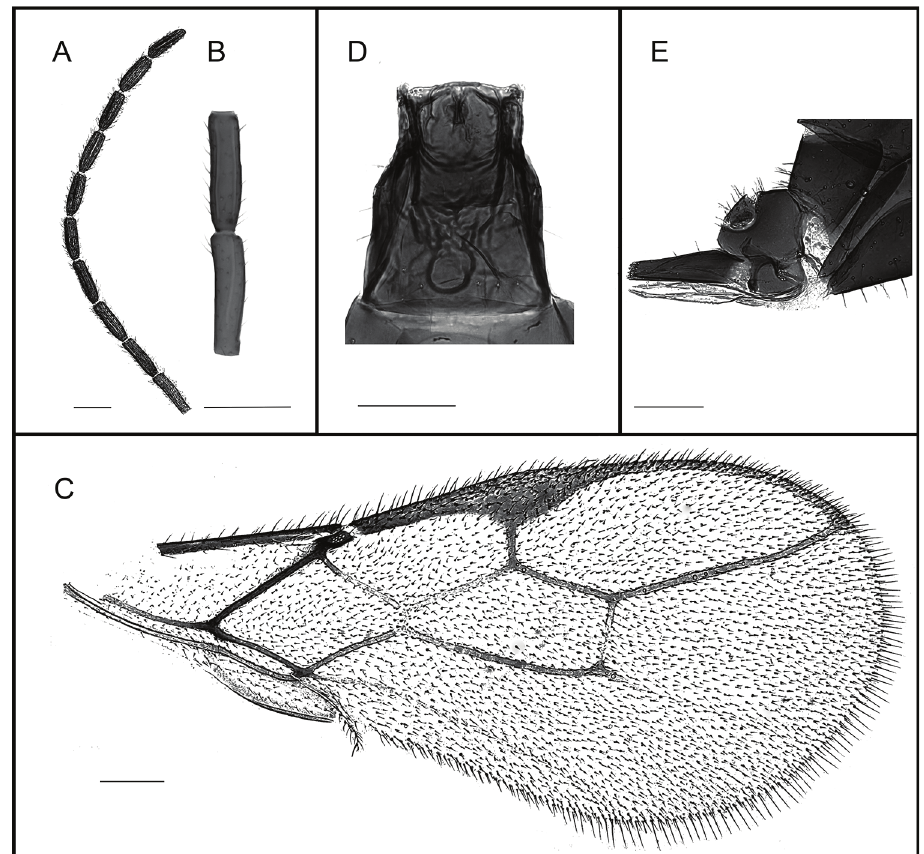
Figure 1. Ephedrus antennalis sp. nov. Tomanović A antenna B first and second flagellar segment C fore- wing D petiole – dorsal aspect E ovipositor sheaths – lateral aspect. Scale bars: 100 Ephedrus carinatus Tomanović, sp. nov.